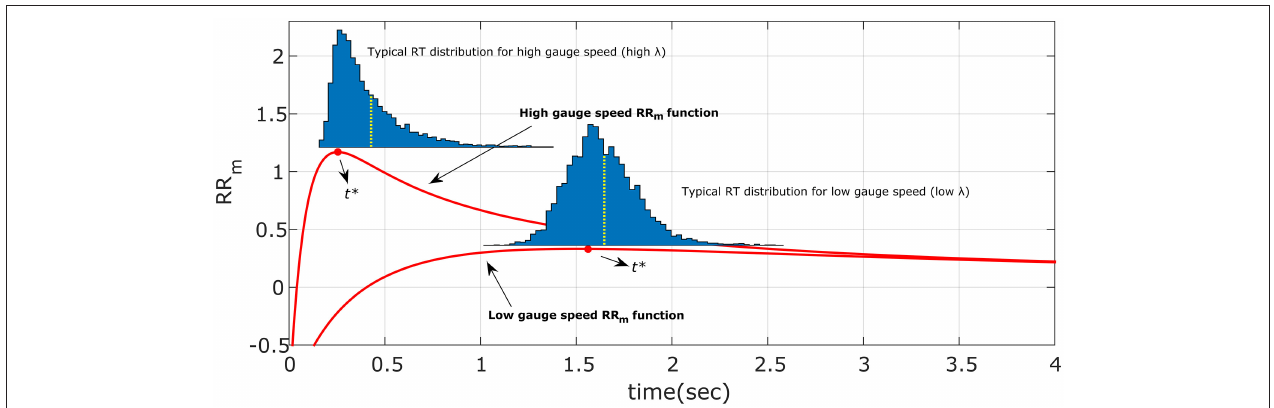
FIGURE 11 | Illustration of the hypothesized optimum distributions for the RR m decision rule. The two RR m functions (in red) for two different gauge speeds (different λ ) are maximized by responding precisely at t * . However, if the response is noisy, the asymmetry of RR m make more profitable in terms of reward rate to err on the right side of t * than on the left. The asymmetry effect is diminished with low gauge speed (small λ ): the distributions are less skewed and more spread out. This also entails that the difference between distribution mean (yellow dotted lines) and t * is greater with high gauge speed. Compare these simulated distributions with the empirical data in Figure 8